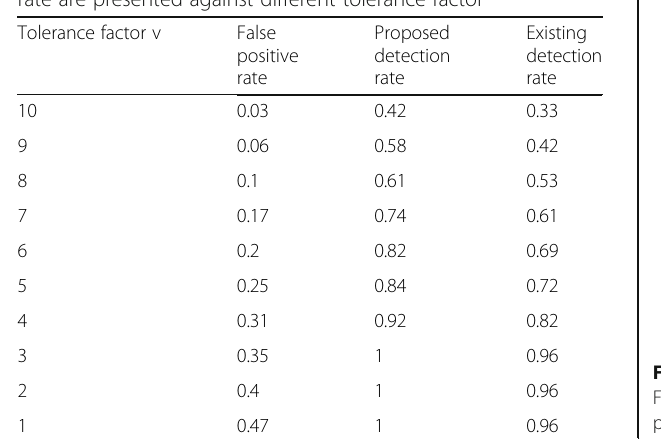
Table 2 Performance in terms of detection rate tolerance factor values are taken from 1 to 10. False positive rate and detection rate are presented against different tolerance factor Tolerance factor v False